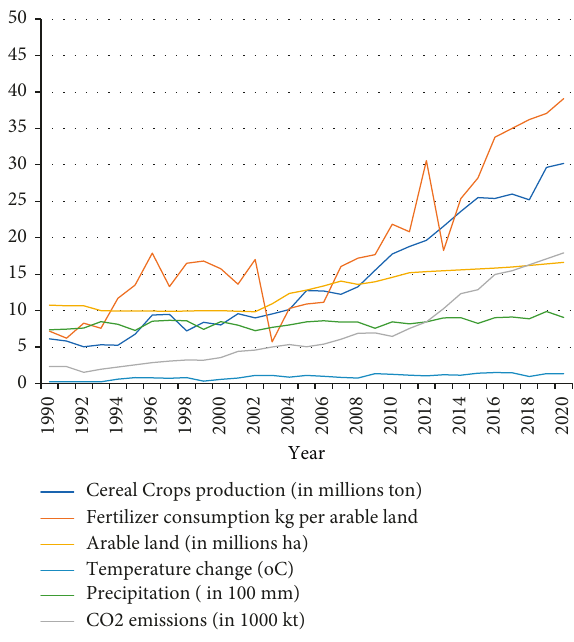
Figure 1: The trend of variables included in the model (1990–2020). Table 2: Results of descriptive statistics of selected